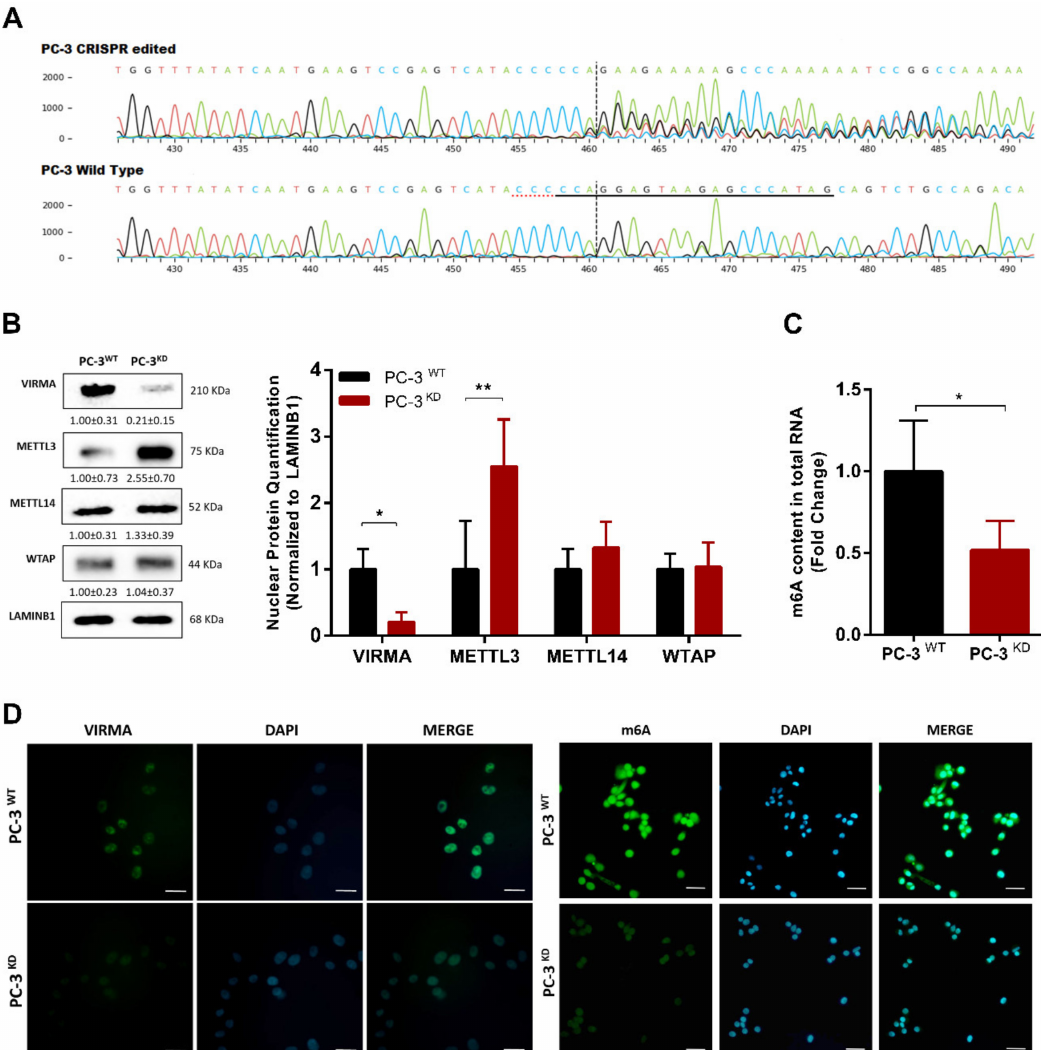
Figure 3. VIRMA knockdown in PC-3 cells caused global m 6 A reduction. ( A ) Sanger sequencing of PC-3 Wild Type (control) and CRISPR edited sequences in the regions around the guide sequence (the horizontal black underlined region represents the RNA guide sequence, the horizontal red underline is the PAM site and the vertical black dotted line represents the cut site); ( B ) Western blot quantification of the total amount of METTL3, METTL14, WTAP, and VIRMA in the nuclear protein fraction after VIRMA knockdown. Relative protein abundance was determined by normalization with LAMINB1. Bars represent mean ± SD based on 3 independent experiments, * p < 0.05, Mann–Whitney U test. ( C ) Global m 6 A modification levels in total RNA after VIRMA silencing in PC-3 cells, * p < 0.05 and ** p < 0.001, Mann–Whitney U test; ( D ) VIRMA expression and m 6 A levels assessed by confocal immunofluorescent assay (scale bar = 20 µ